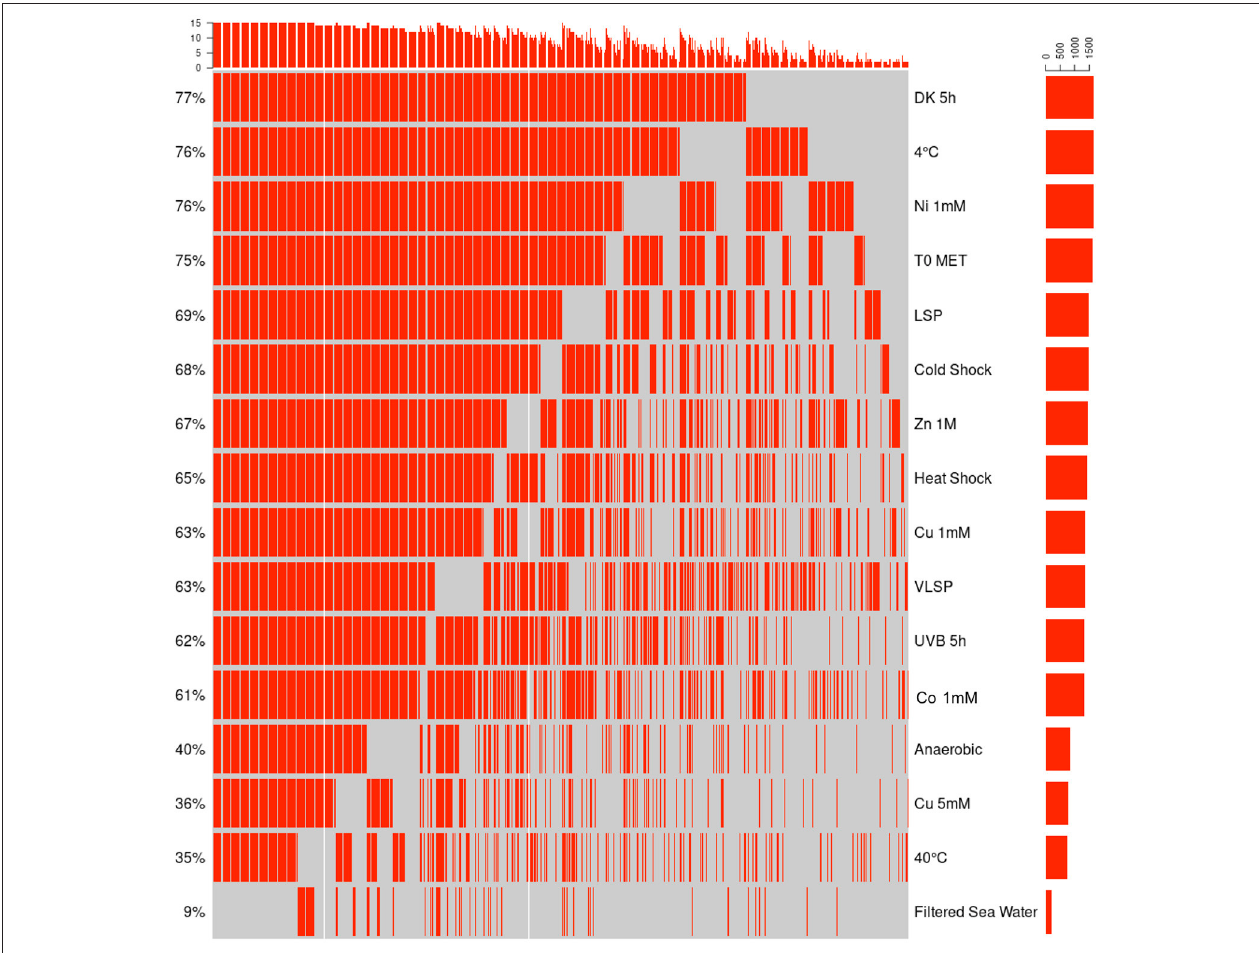
FIGURE 7 | Qualitative visualization (oncoprint) of the accessory proteome. The x-axis represents the identified proteins (red, non-identified proteins in gray), the y-axis the different